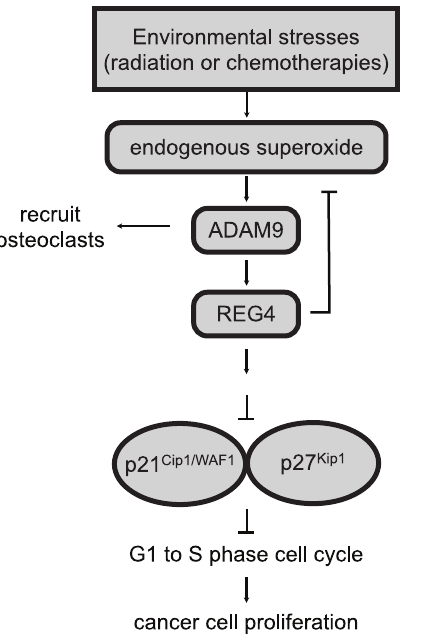
Figure 7. Scheme demonstrated the role of ADAM9 in the regulation of REG4 and p21 Cip1/WAF1 /p27 Kip1 activities in prostate cancer cells during environmental stresses, such as radiation therapy or Figure S1 Scheme illustration of retroviral (up) and lentiviral (bottom) shRNA targets to ADAM9 mRNA and lentiviral shRNA targets to Reg4 mRNA. Targeted sequences were listed. Figure S2 (a) Immunoblotting validated ADAM9 expression and revealed the knockdown of ADAM9 by Retroviral shA- DAM9-17130. Vector, pSM2C, were also transfected into PC3 and used as negative control. To select knockdown clone, several clones were also examined. Clone 7 was selected and used in most of our studies. (b) Immunoblotting confirmed knockdown effects of ADAM9 gene in PC3 using lentivral knockdown systems. 46978 and 46980 were selected and shGFP were used as control studies.